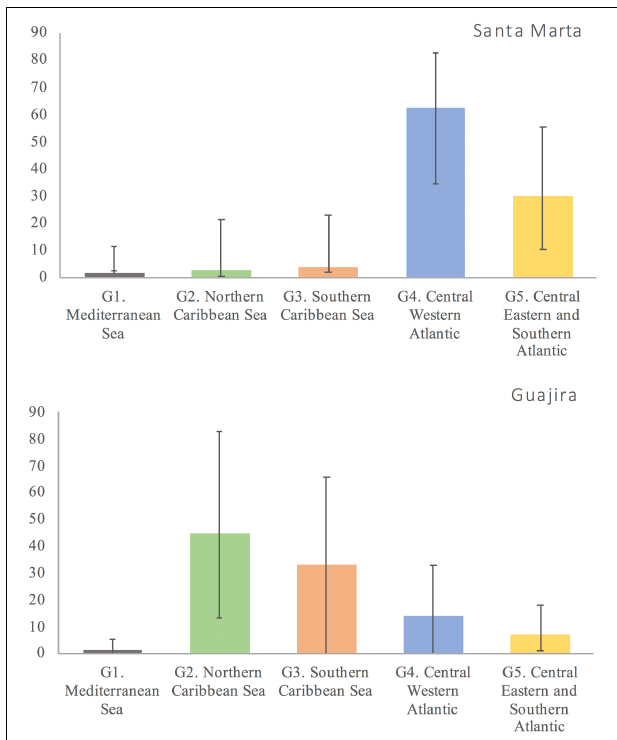
FIGURE 5 | Contributions of genetically distinct Chelonia mydas nesting rookery groups in the Atlantic to the mixed stocks in northeastern Colombia during two seasons “wet” and “dry,” inferred with Bayesian mixed stock analysis (Bolker et al.,